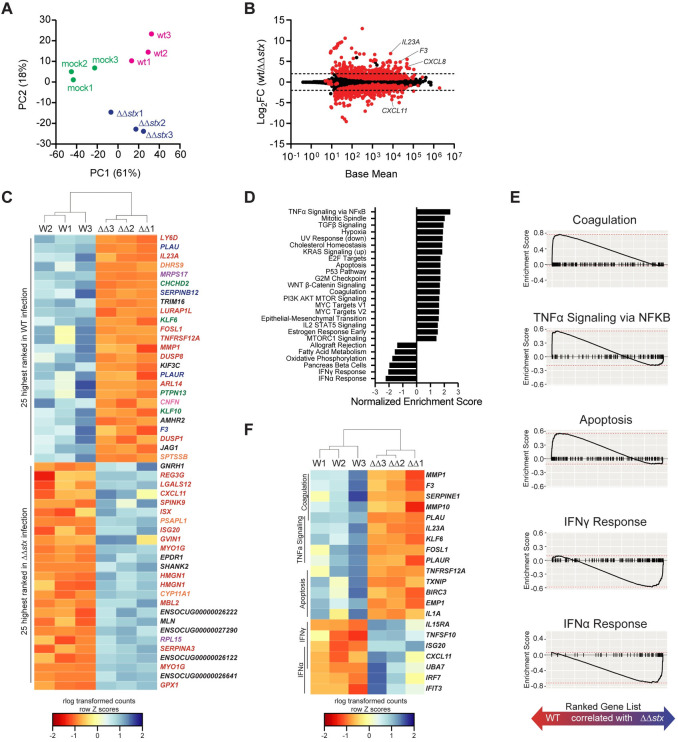
Profiles of colonic epithelial cell transcriptional responses differ between animals infected with WT and ΔΔstx EHEC.(A) Principal component analysis of rlog-transformed expression values. (B) Average expression level (base mean) and log2 fold change of transcript abundance from rabbits inoculated with WT or ΔΔstx EHEC. Red dots are genes with significantly different (p<0.05) transcript abundance. Dashed line indicates log2 fold change >2 or <-2. (C) Heat map of rlog-transformed read counts for top 25 and bottom 25 genes by rank. Rows are Z-normalized. Gene names are colored by function: red–immune, orange–metabolism, green–proliferation/apoptosis, blue–coagulation, purple–translation/protein folding, pink–barrier function/cytoskeleton, black–uncharacterized or other. (D) Hallmark gene sets significantly associated with WT or ΔΔstx infection. (E) Gene set enrichment plot for selected pathways. Black tick marks are genes within pathway organized by rank. (F) Heat map of rlog-transformed read counts for top 5 genes in the leading edge for indicated pathway organized by rank.